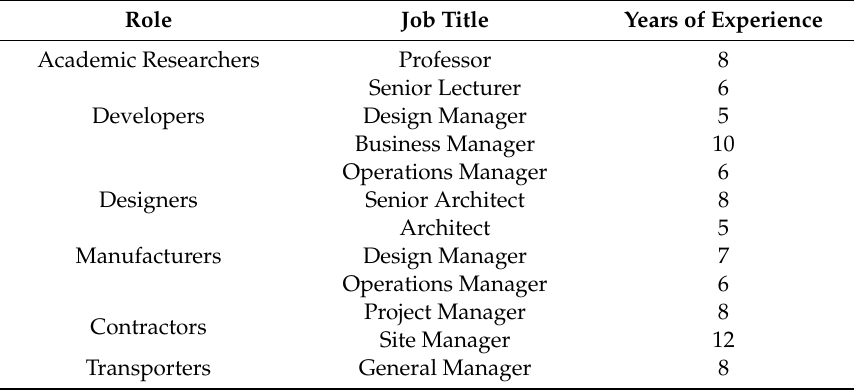
Table 2. Information on experts for focus group